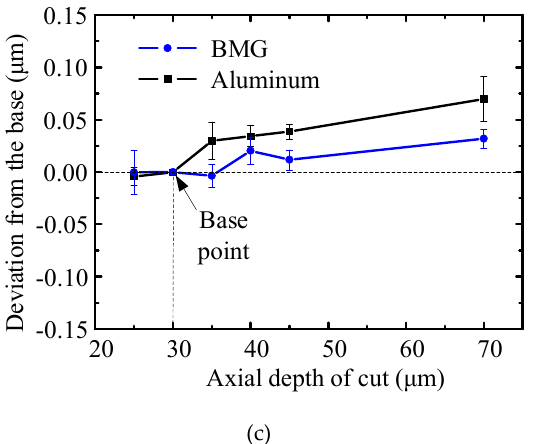
Figure 12. The influence of milling parameters on surface roughness. ( a ) The influence of rotation speed; ( b ) the influence of feed rate; ( c ) the influence of axial depth of cut.